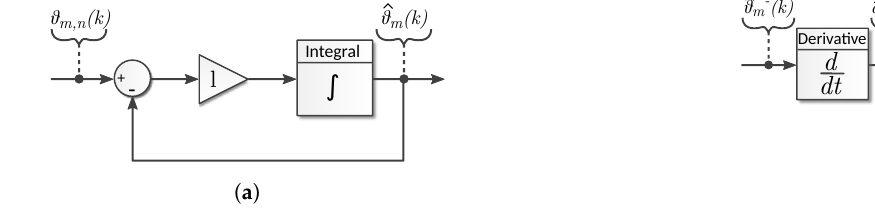
ˆ θ m ( k ) ( a ) and the output vs. θ m,n ( k )